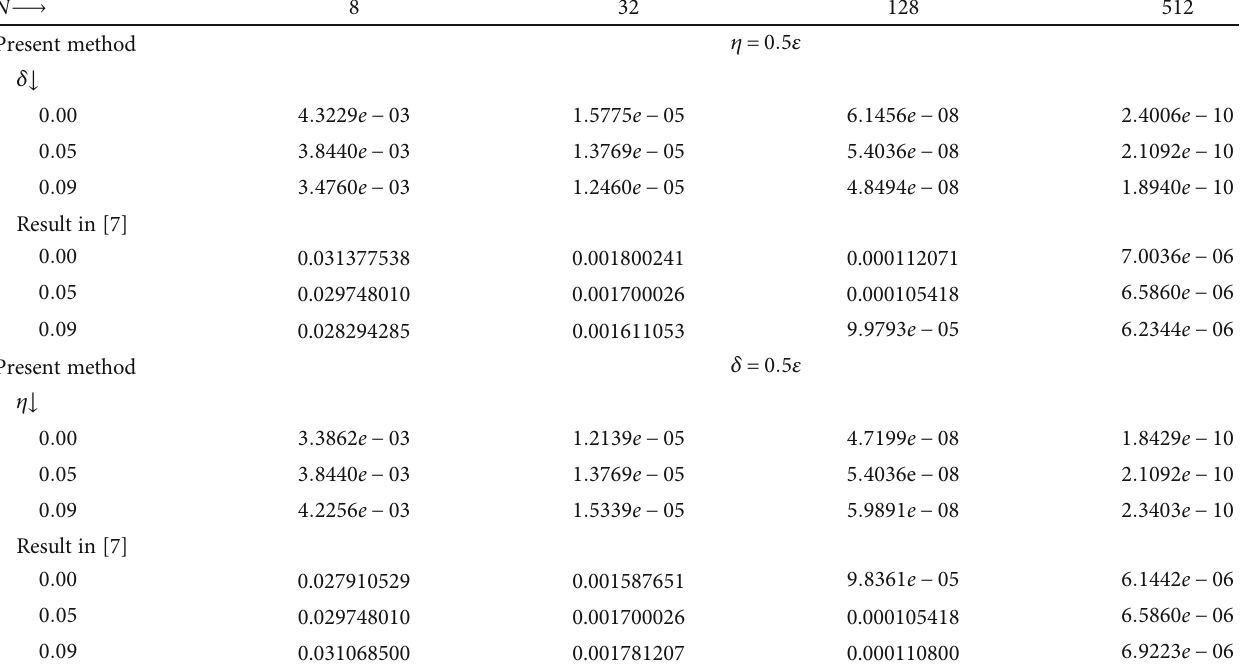
Table 2: Maximum absolute error of Example 5 for ε = 0 : 1 .